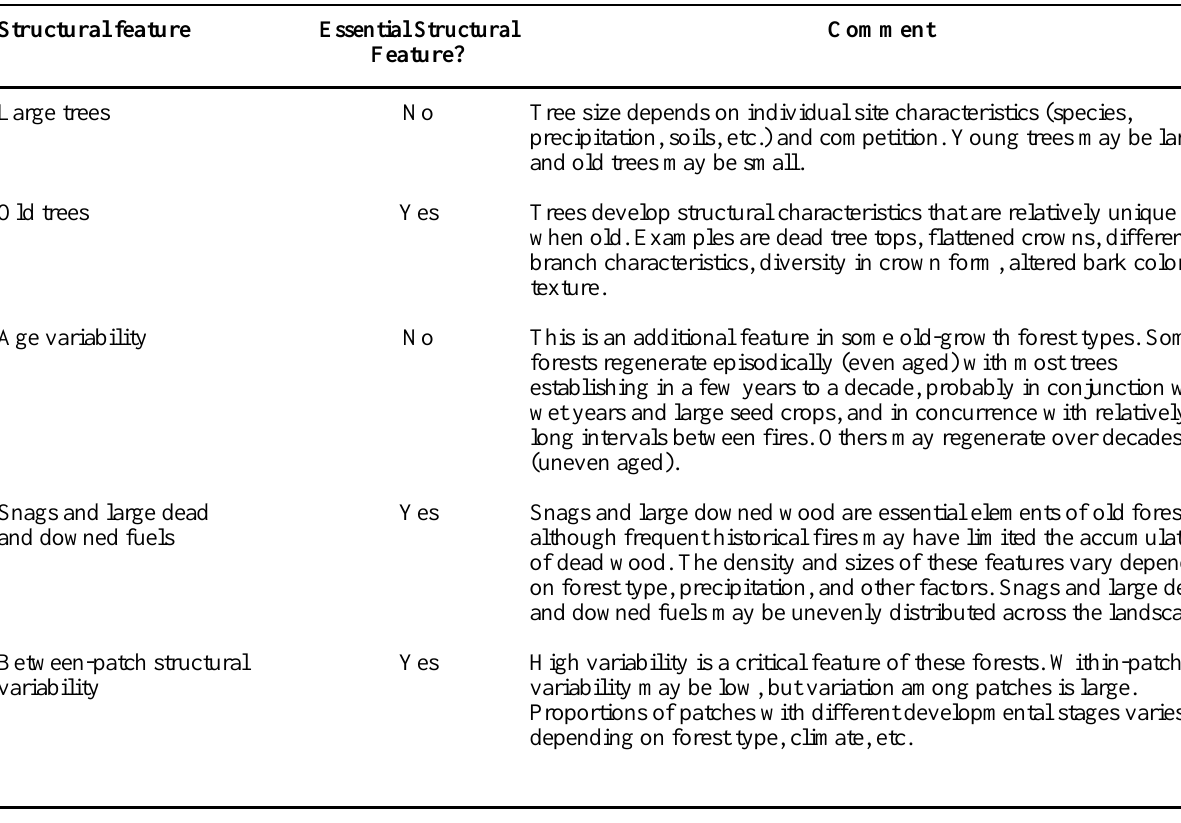
Table 1. Essential structural features of old growth in fire-adapted forests. Note that whether or not a feature is essential may depend on scale, e.g., patch, stand, or landscape. For example, age variability is likely at a landscape scale, and snags and large dead and downed fuels may not exist in some